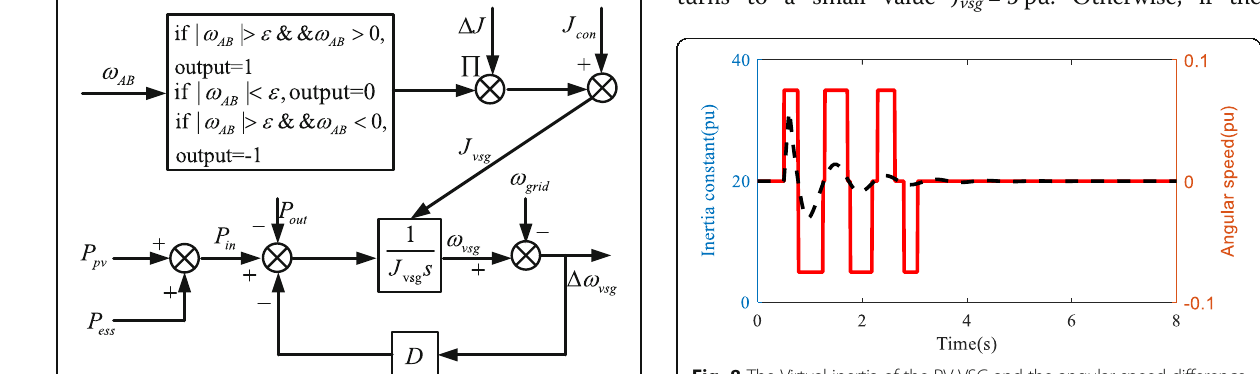
Fig. 8 The Virtual inertia of the PV-VSG and the angular speed difference under the variable inertia